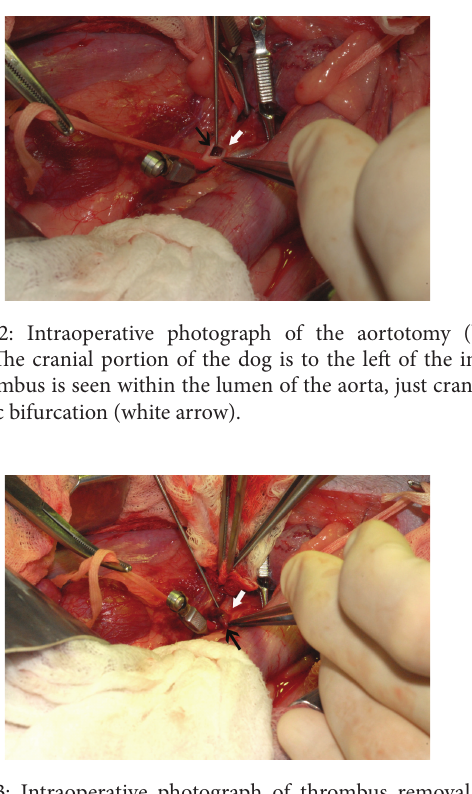
Figure 3: Intraoperative photograph of thrombus removal. The cranial portion of the dog is to the left of the image. The thrombus (black arrow) is removed from the aorta, at the level of the aortic bifurcation (white